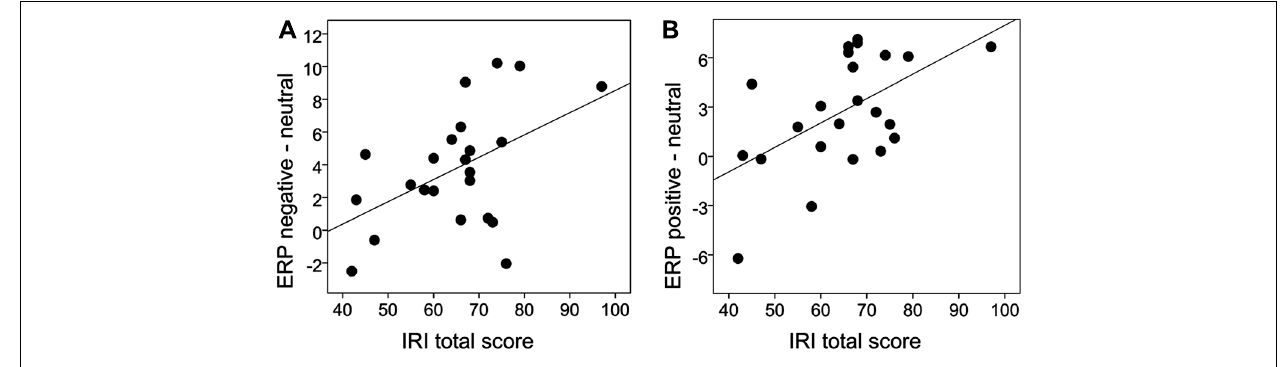
FIGURE 5 | Scatterplot of the correlation between the P3 effect and IRI total score. The P3 effect was quantified as the difference in the ERP waveform activity between emotional and neutralT2 pictures (i.e., negative-neutral, positive-neutral) in the time window of 300–800 ms.